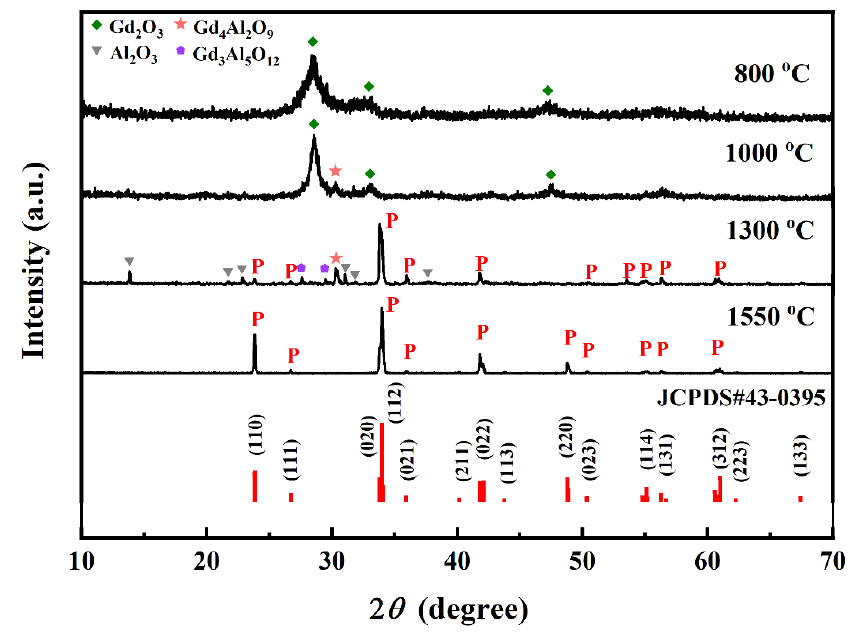
Figure 4. XRD patterns of the ceramic film calcined at different temperatures.